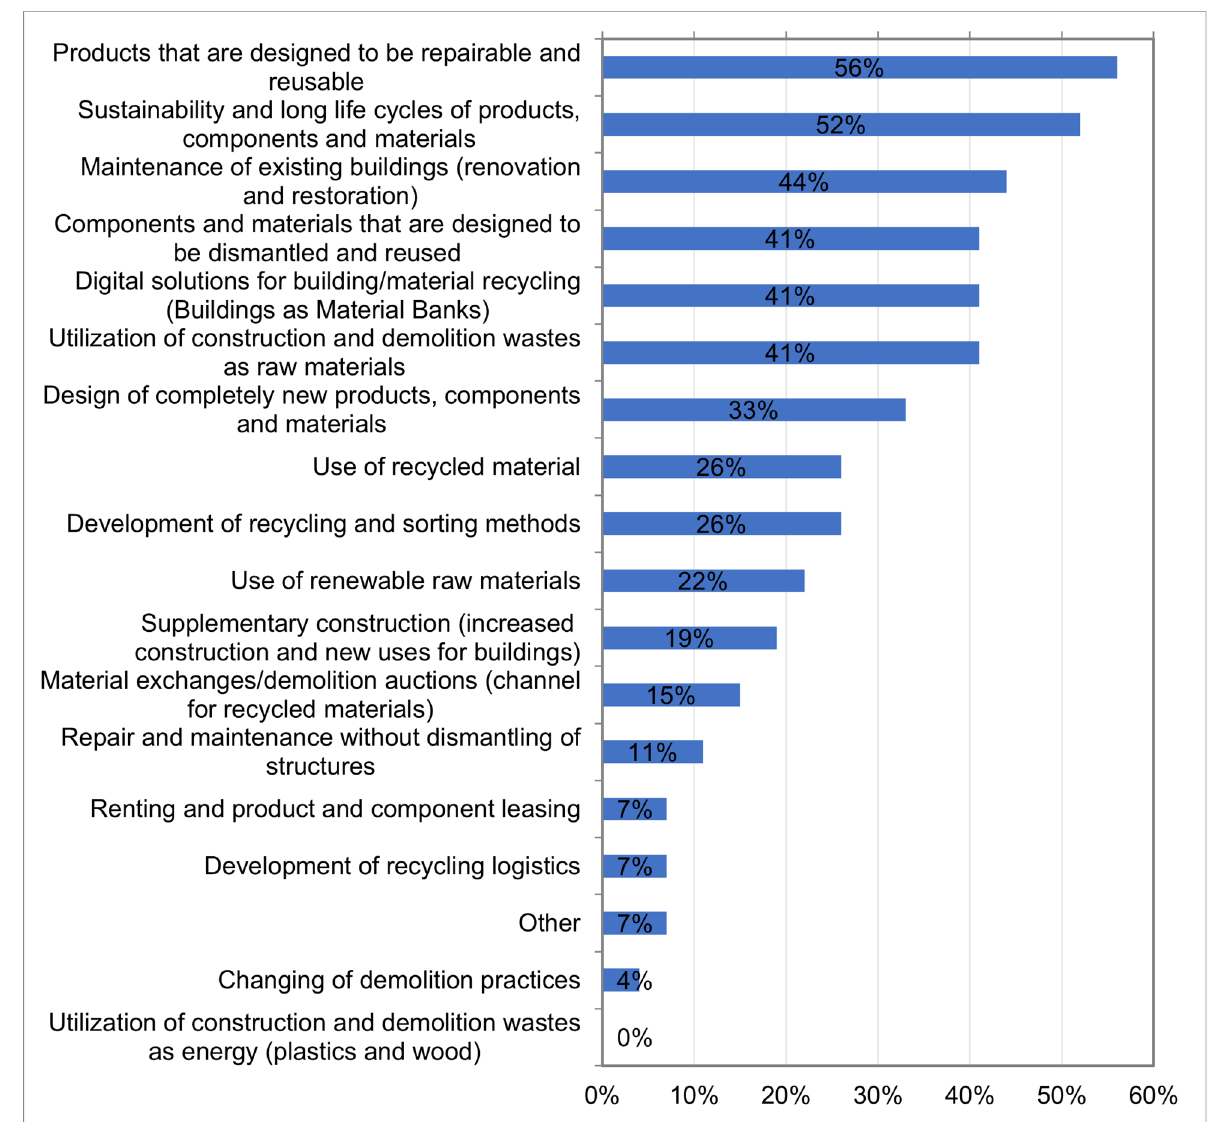
Figure 2. Most important circular economy drivers and opportunities in the construction sector.